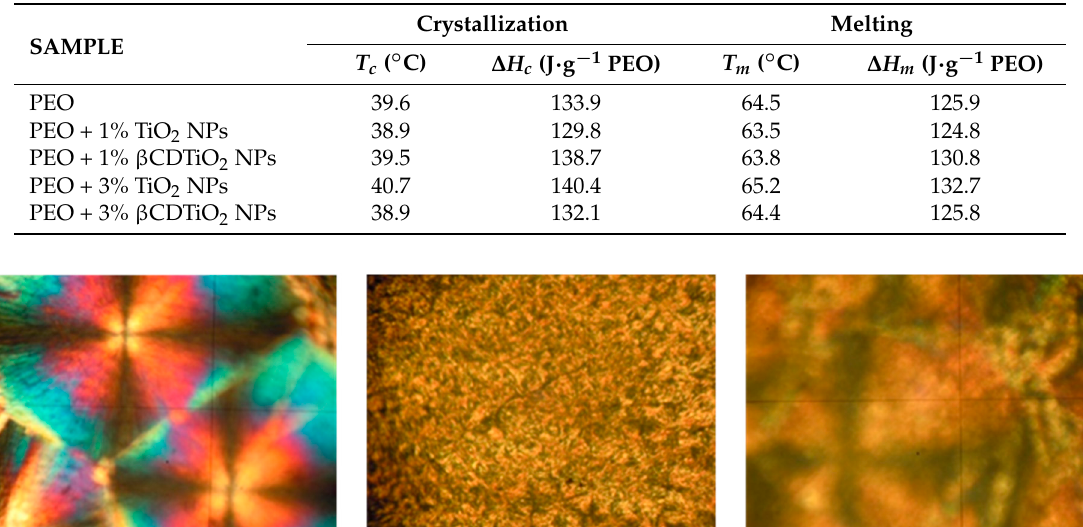
Table 2. Crystallization and melting temperatures and enthalpies of PEO and its mixtures with 1% and 3% TiO 2 NPs and β CDTiO 2 NPs.